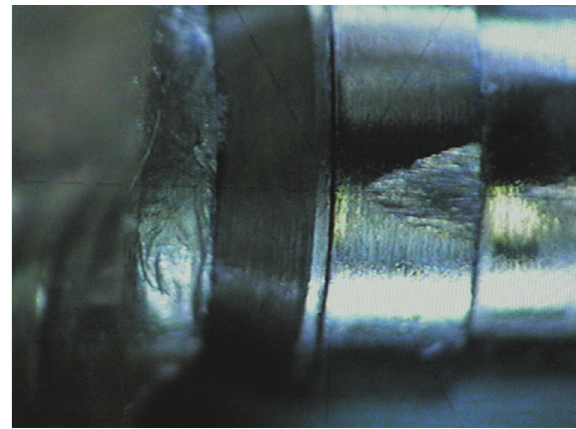
Figure 3- Microscopic image of the misfit generated at the interface of one point